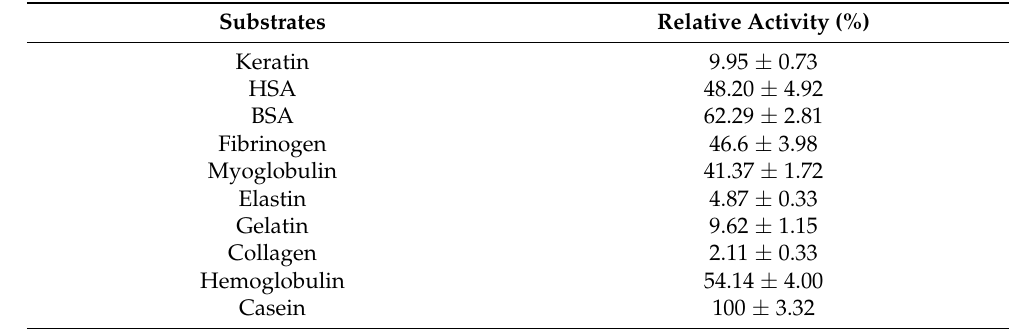
Table 2. The activity of S. speibonae TKU048 protease on different substrates. The protease activity toward casein was set as 100% relative activity. All data points are means ± S.D. of three different experiments (each experiment was conducted in